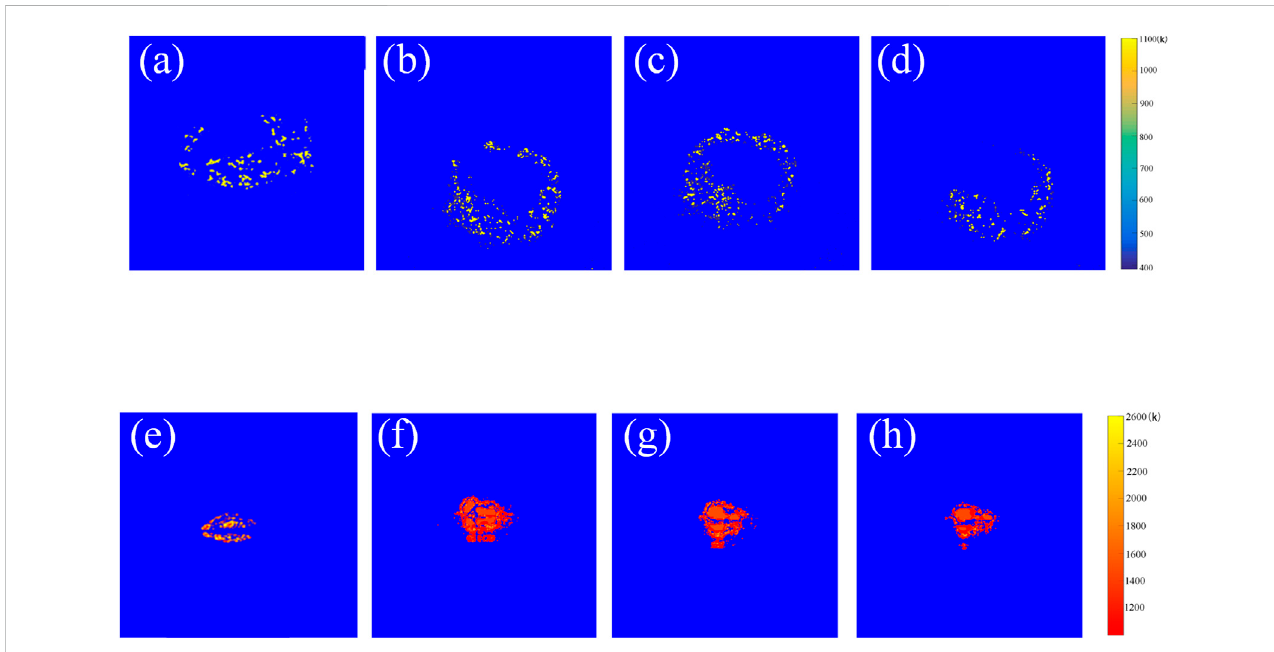
FIGURE 3 Combustion temperature distributions (A) pure iron nanoparticles, (B) 10 wt% (Fe/TiO 2 ), (C) 20 wt% (Fe/TiO 2 ), (D) 30 wt% (Fe/TiO 2 ), (E) pure aluminum nanoparticles, (F) 10 wt% (Al/TiO 2 ), (G) 20 wt% (Al/TiO 2 ), (H) 30 wt% (Al/TiO 2